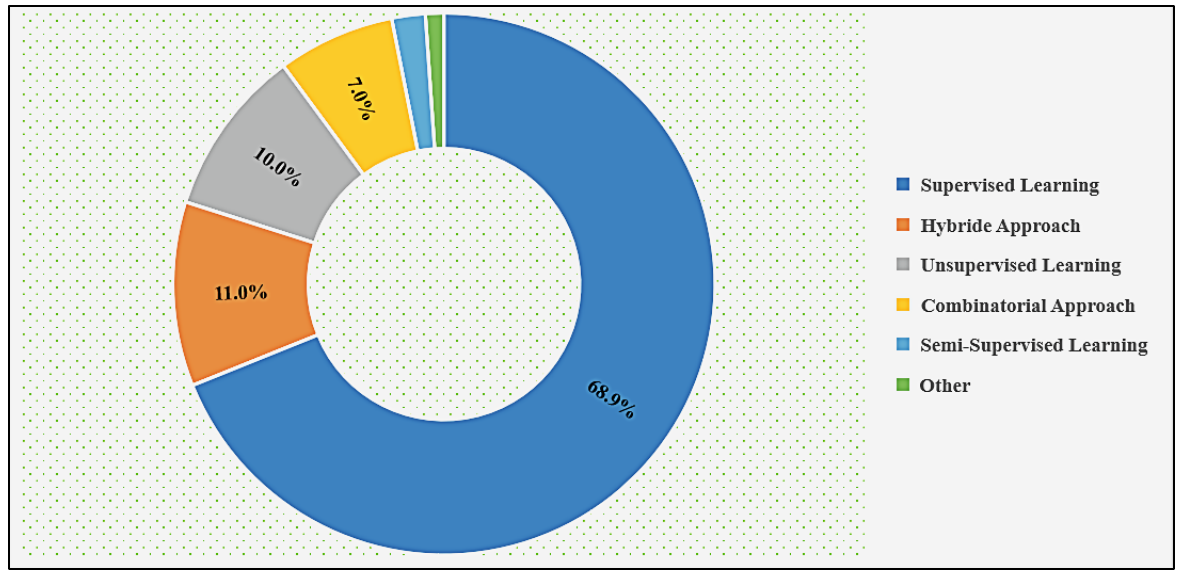
Figure 2. Distribution of the different ML categories in the chemical industry applications.